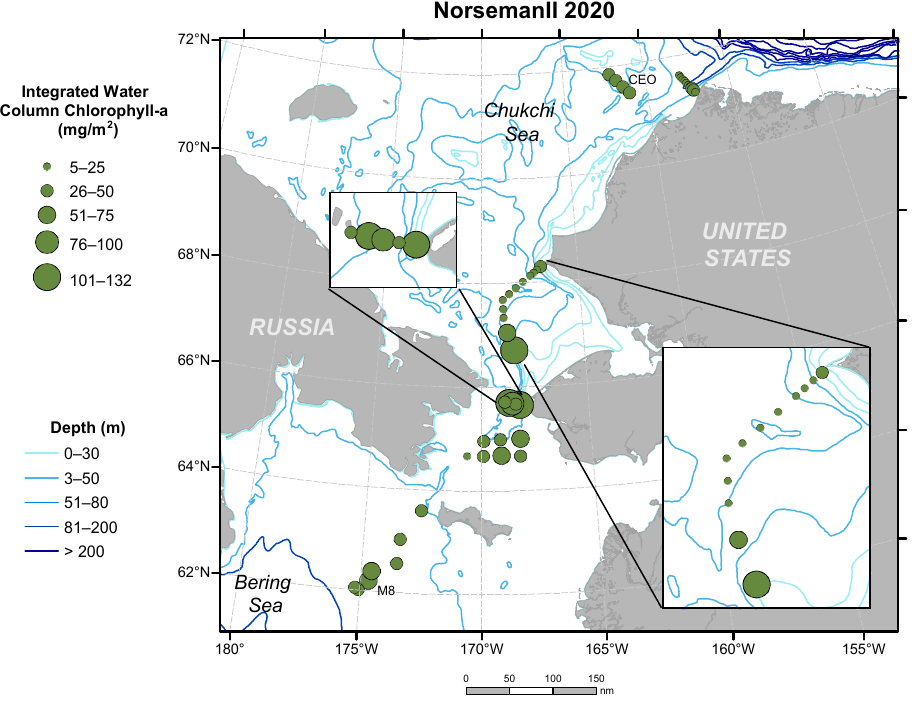
Figure 4. Spatial variation in integrated chlorophyll over whole water column during October 2020 RV Norseman II cruise.